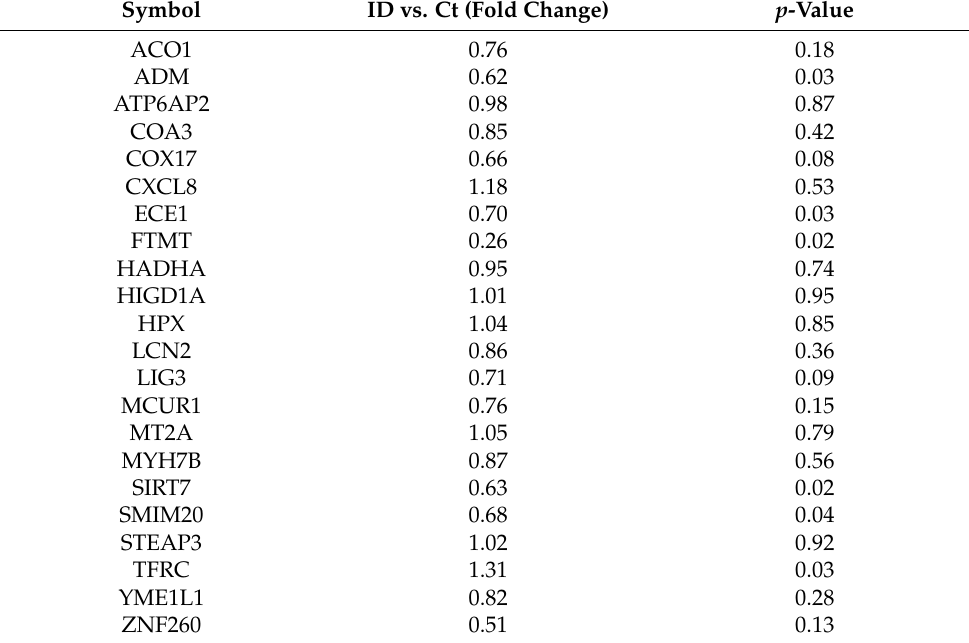
Table 3. Fold-change of candidate genes in a chronic HF population with systemic ID versus no-ID. Symbol ID vs. Ct (Fold Change) p -Value ACO1 0.76